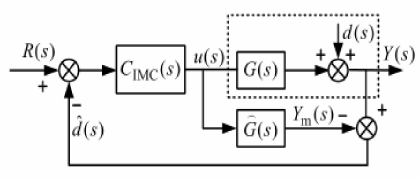
Figure 13. The structure diagram of